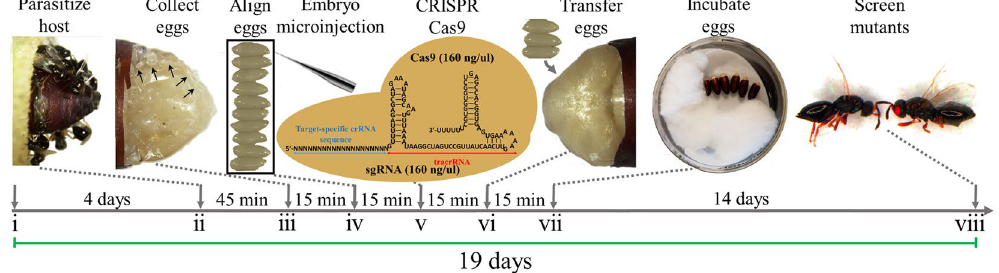
Figure 1. Schematic of Nasonia vitripennis embryo collection and CRISPR/Cas9 microinjections. Adult Nasonia vitripennis were mated for 4 days (i), then were supplied with a flesh fly host pupa, Sarcophaga bullata , for female parasitization for 45 minutes (ii). Embryos were then collected from the host (iii), aligned (iv), and injected with CRISPR/Cas9 components (v). Injected embryos were then gently placed back into the host (vi) for development (14 days) (vii), and when the adults emerged from the host they were subsequently screened for CRISPR/Cas9 induced mutations in target gene (viii). This entire procedure takes roughly 19 days to